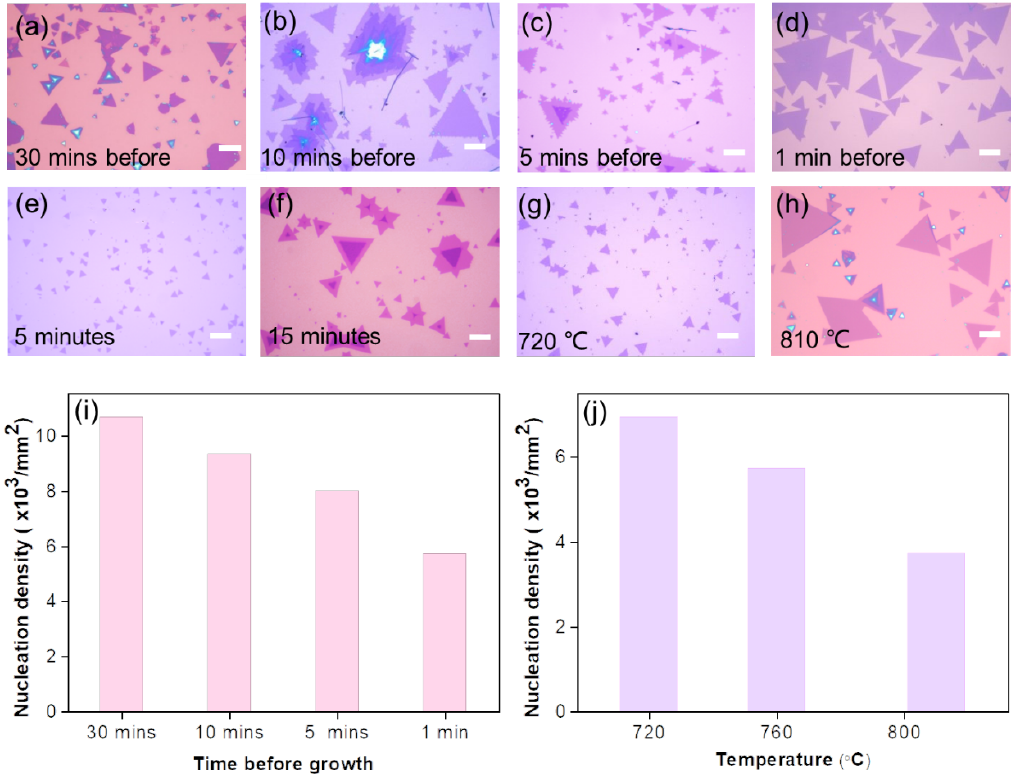
Figure 2. ( a – d ) Optical images of MoSe 2 samples grown at 760 °C for 10 min, when the switch time turning reverse- to forward-flow ( a ) 30 min ( b ) 10 min ( c ) 5 min ( d ) 1 min before reaching 760 °C, respectively. ( e – h ) Optical images of MoSe 2 samples when the switch time turning reverse- to forward-flow (Ar/H 2 , 45 sccm/5 sccm) 1 min before reaching growth temperature. The growth time is ( e ) 5 min and ( f ) 15 min at 760 °C, respectively. The growth temperature is ( g ) 720 °C and ( h ) 810 °C, with 10 min growth time. Statistical variation of nucleation density with ( i ) growth time and ( j ) temperature. A mixture of Ar/H 2 (45 sccm/5 sccm) was applied in ( a – h ). The scale bar is 10 μm.